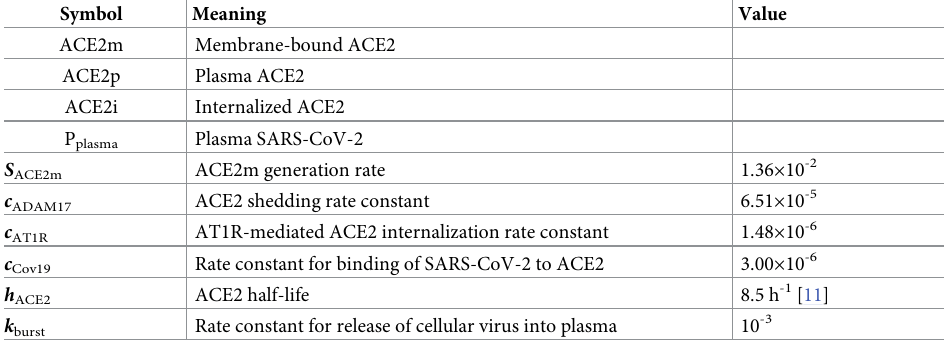
Table 3. Predicted variables and parameters for ACE2 dynamics. Baseline values are given for model